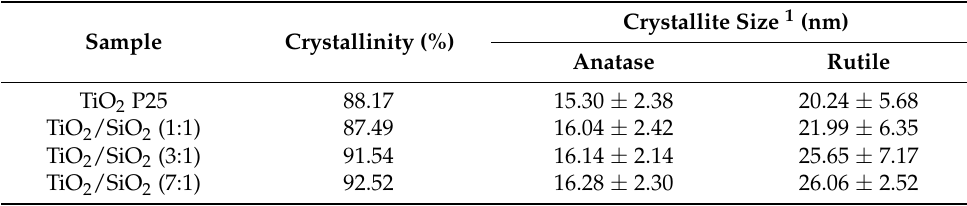
Table 2. The crystallinity and crystallite size of the samples. Sample